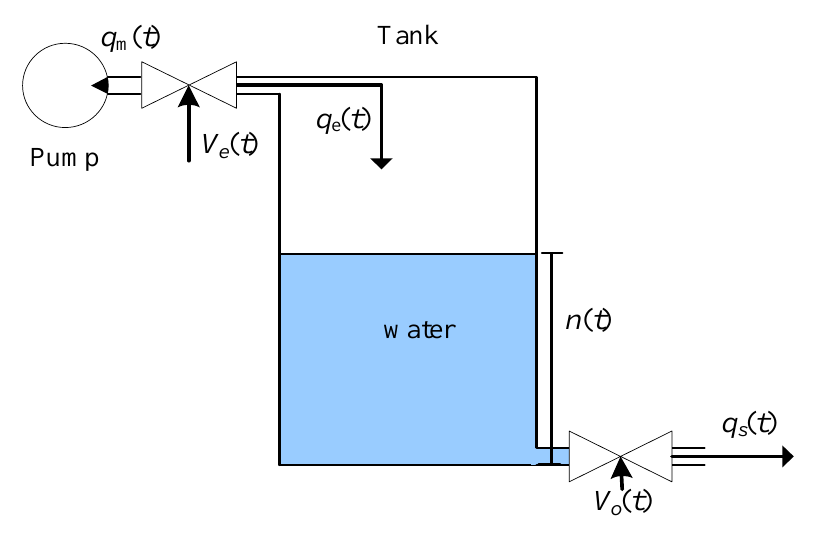
Figure 8. Dynamic system simulated in real time using the prototype.